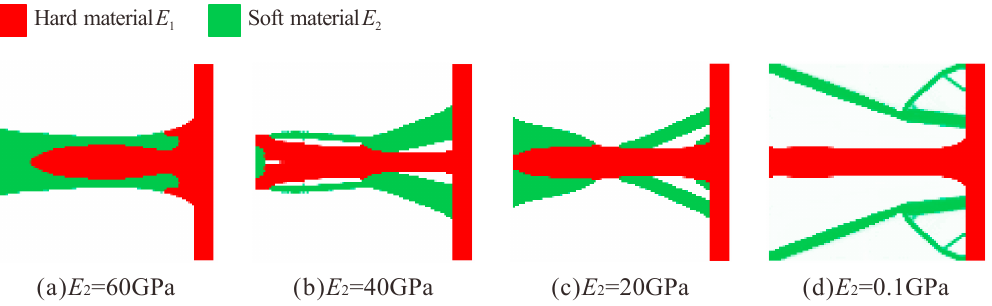
Figure 7. Topology optimization results of multi-material flexure hinge for different Young’s modulus combinations. ( a ) E 2 = 60 GPa, ( b ) E 2 = 40 GPa, ( c ) E 2 = 20 GPa, ( d ) E 2 = 0.1 GPa ( E 1 = 71 GPa for all cases).